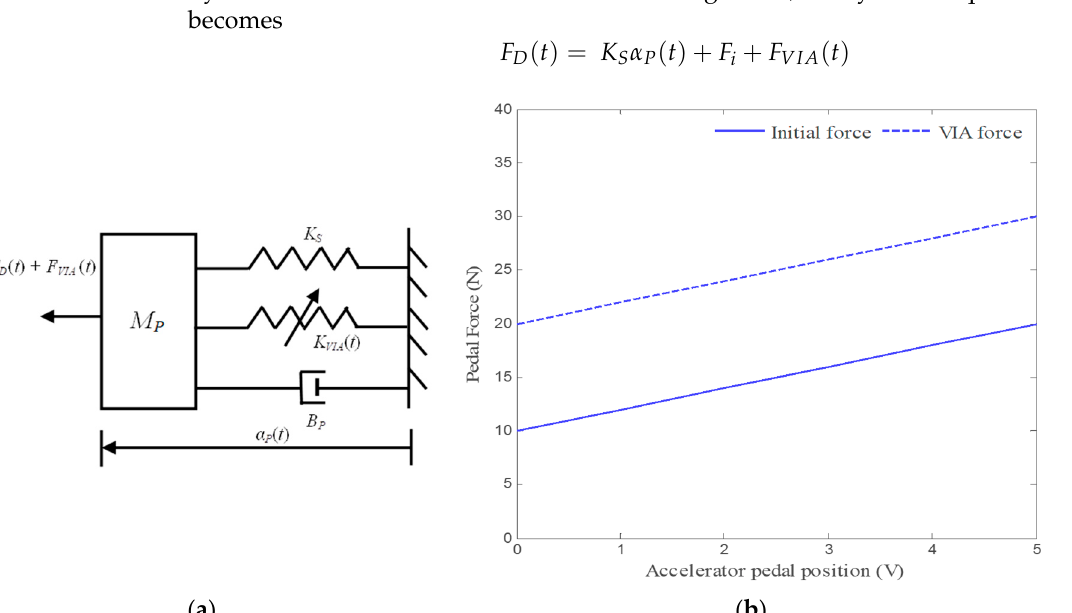
Figure 3. Mechanical model and characteristics; ( a ) schematic mechanical equivalent of the AAP dynamics with force feedback, ( b ) position–force relationship of the AAP.